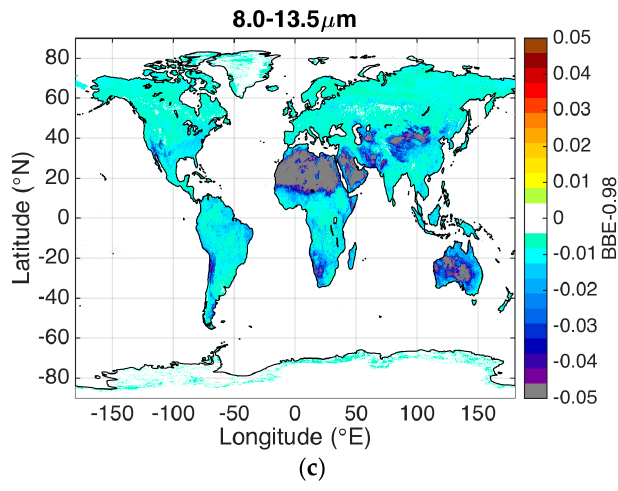
Figure 5. CAMEL 8.0–13.5 µm January 2007 BBE minus ( a ) 0.96; ( b ) 0.97 and; ( c ) 0.98.